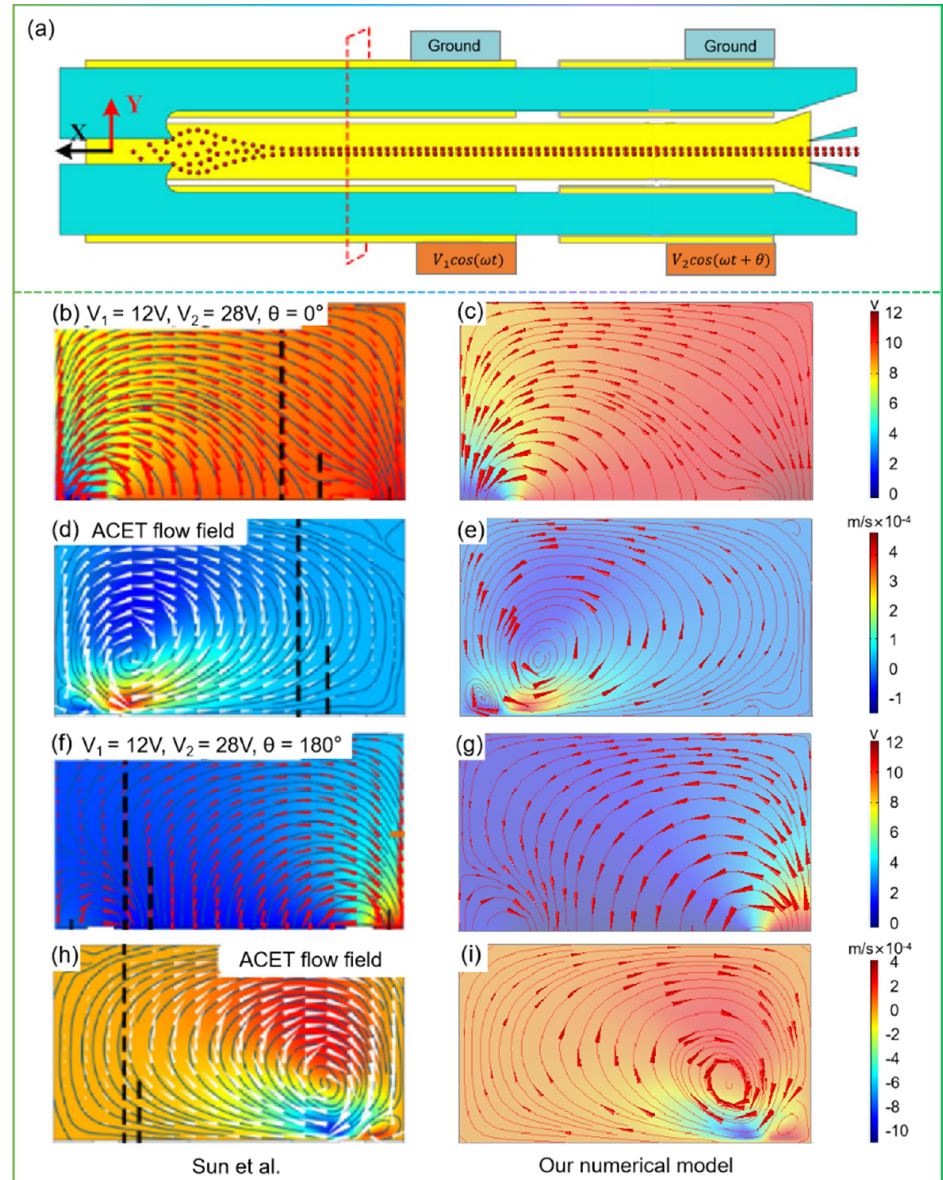
Figure A2. Model evaluation (validation of the electric field and the electrothermal flow): ( a ) Sche- matic diagram of the separator from Sun et al. (the simulated cross section is highlighted by the red dashed frame); Electric field comparison: ( b , f ) calculations from Sun et al. and ( c , g ) calculations using the proposed model from this work; Fluid flow comparison: ( d,h ) calculations from Sun et al. and ( e , i ) calculations using the proposed model from this work. Operating parameters: (b – e) 𝑢 = 25 e - 6 m/s, σ (cid:3040) = 0.1 S/m, f = 1 MHz, V 1 = 12 V, V 2 = 28 V, θ = 0 ° ; (f – i) 𝑢 = 25 e - 6 m/s, σ (cid:3040) = 0.1 S/m, f = 1 MHz, V 1 = 12 V, V 2 = 28 V, θ = 180°.